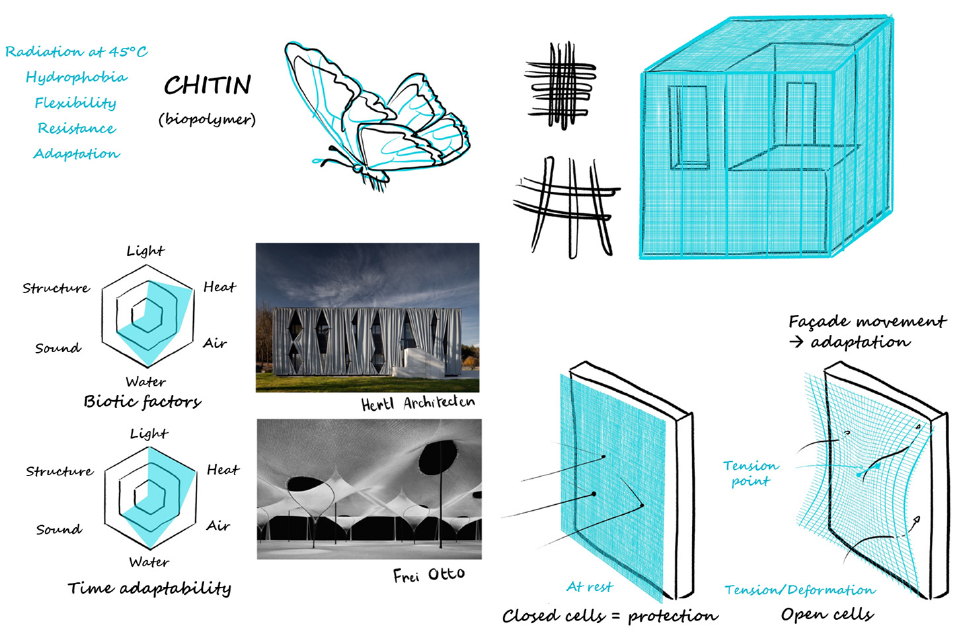
Figure 1. Proposed concept inspired from the Morpho. Credit: Myriame Ali-Oualla and Kaïs Bhouri. Abstraction from the ideation phase led to a concept of a membrane, both flexible and ductal, similar to the wings of the Morpho made of chitin polymer. The structure is a deformable mesh made of identical solid elements held together. When the mesh is deformed, the elements are pushed away from each other, creating openings between them. The elements themselves are deployable using flaps that can rotate on a base. The rotation is induced either by the deformation or by a manually operated device. Additional func- tionality is brought by a coating on the flaps, which has an adaptive absorption coefficient linked to changes in temperature. Table 2 lists the functions managed by this concept in some of the possible configurations. The adaptive properties of this concept were chosen to be both auto-reactive (coating, flaps) and mechanically operated by the building occupants (deformation, Table 2. Managed functions according to configurations. For visual display, flaps are white and base elements are dark grey.